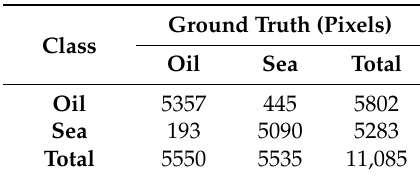
Table 9. Confusion matrix achieved by SVM based on 10π/2 mode features.